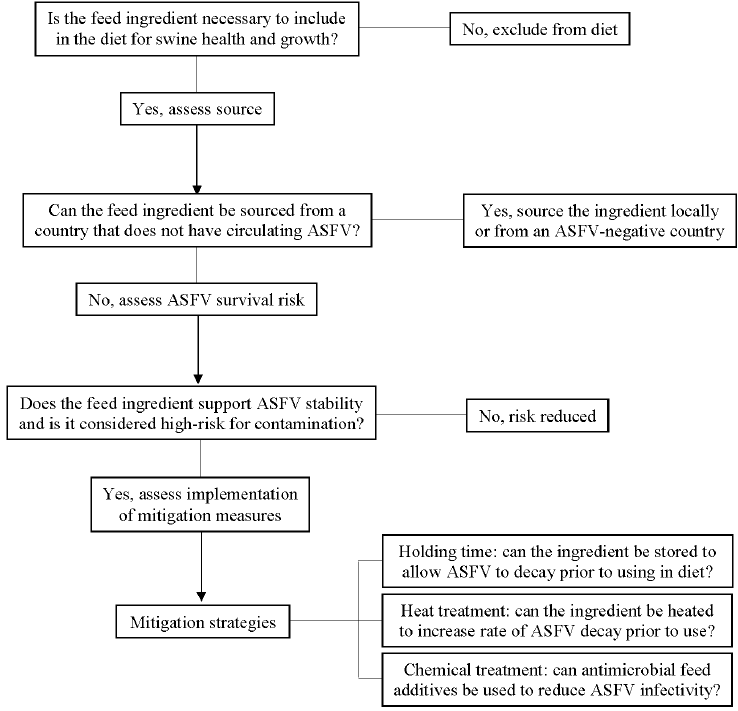
Figure 3. Risk assessment for feed ingredients as transboundary vectors of swine viral diseases. Adapted and modified from the Feed Ingredient Safety Decision Tree Matrix [75] .